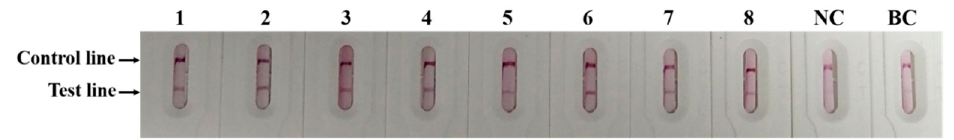
Figure 5. Detection of transgenic samples: NC, negative control, non-transgenic goat DNA; BC, blank control, water. Lines 1–8 represent transgenic goat DNA.